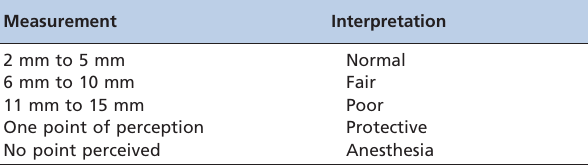
Table 2 - Two-point discrimination test results and